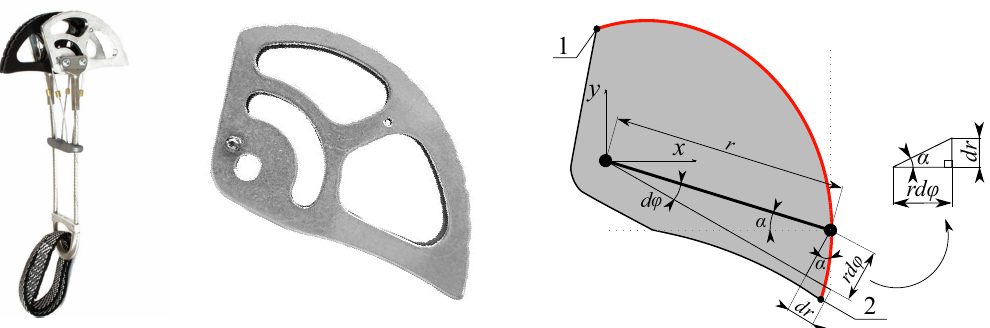
Figure 3. The PB6 SLCD produced by Petr Kouba [7], its cam and a simplified cam model for determination of its contact shape (points on curve: 1—starting point, 2—end